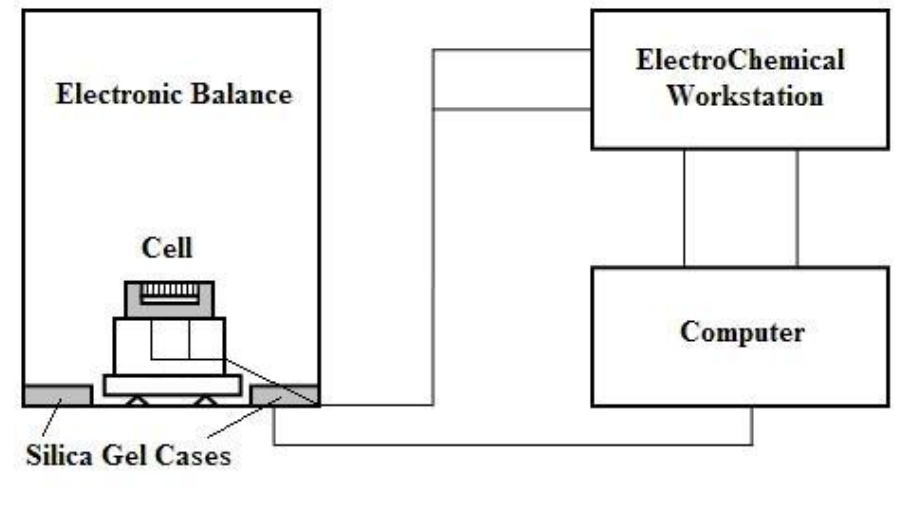
Figure 2. The EIS measuring system